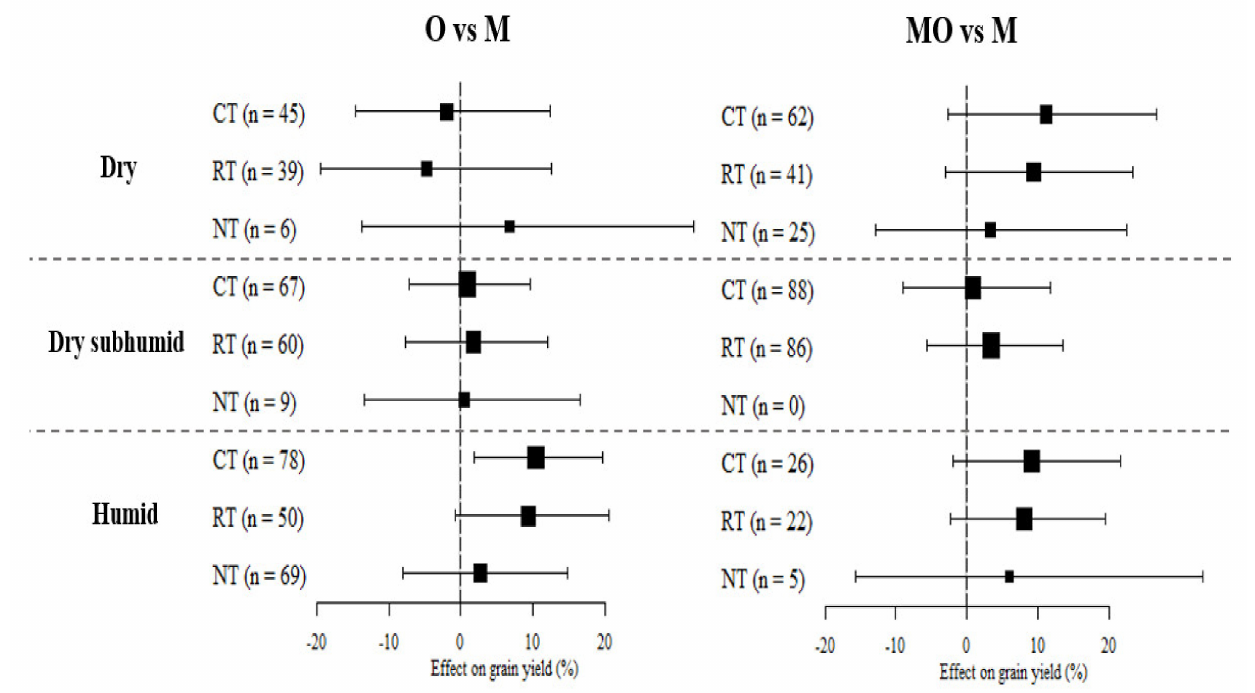
Figure 4. The crop yield response of organic vs. mineral (O vs. M), and mineral + organic vs. mineral (MO vs. M) under conventional, reduced and no-tillage practices (CT, RT, and NT, respectively) in different climatic conditions expressed as the average effect on crop yield (%). “n” refers to the number of observations for each subgroup. The vertical line represents the null hypothesis [ ln ( RR ) = 0]. The squares are the point estimate of effect size. The horizontal lines are the associated 95% confidence interval for the population